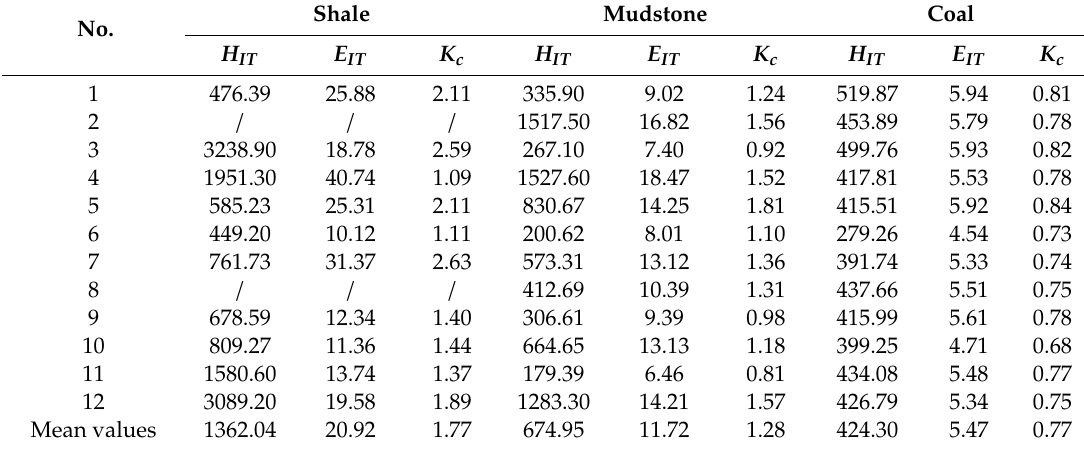
Table 1. Micromechanical parameters of shale, mudstone, and